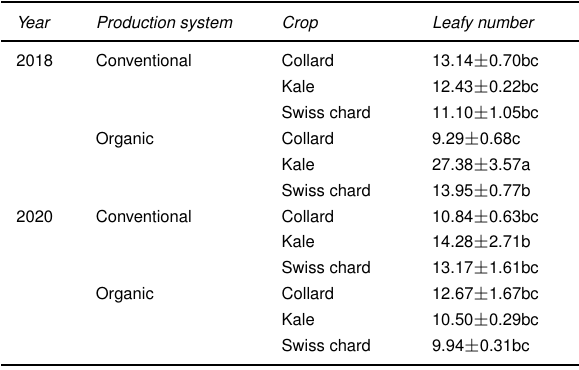
Table 3. Mean ( ± standard error) leaf number of leafy greens (collard, kale, swiss chard) grown in the year (2018 and 2020) in two production systems (organic and conven-